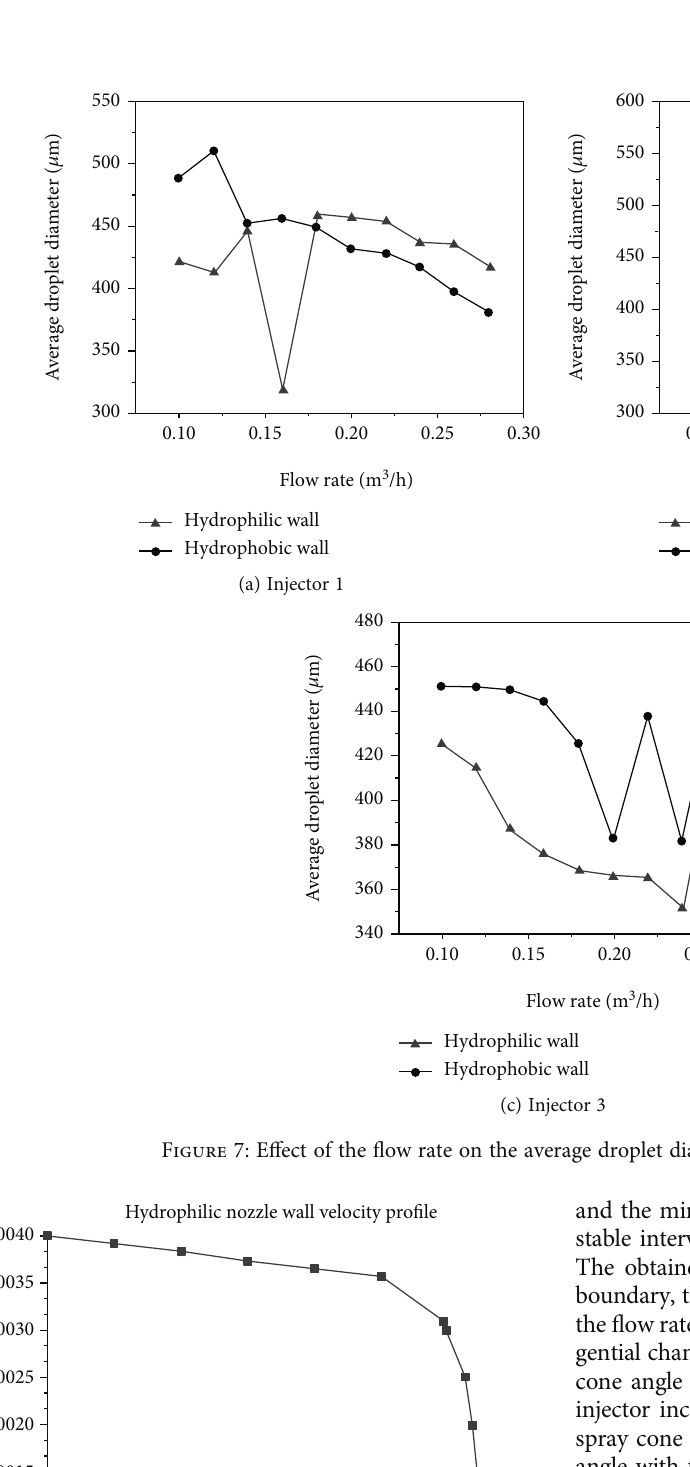
0.00000.00050.00100.00150.00200.00250.00300.00350.0040 m ) ( Y